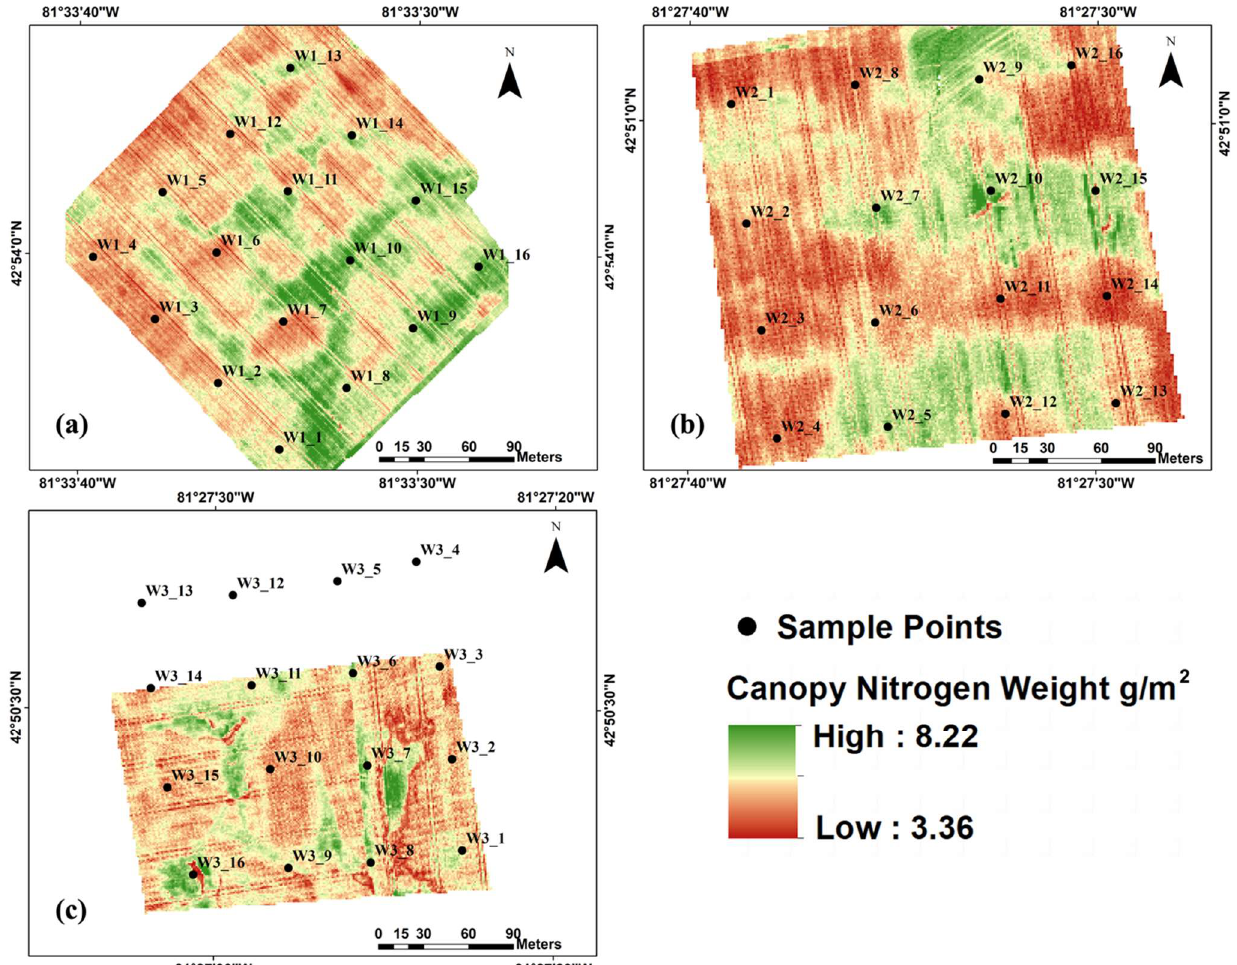
Figure 7. UAV-based prediction maps of canopy nitrogen weight derived from the top 7 variables in the 12, 20, and 27 May SVR model for ( a ) W1, ( b ) W2, and ( c ) W3 wheat fields.